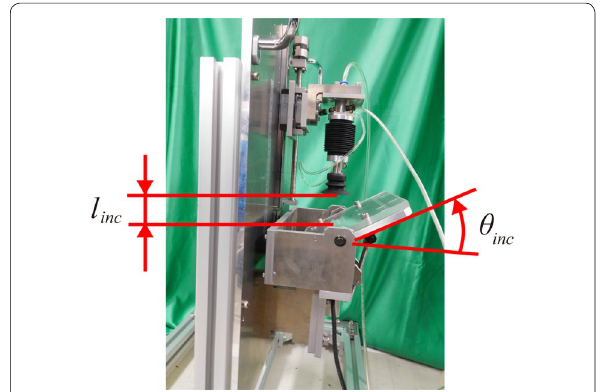
Fig. 16 Experimental parameters for tolerance evaluation